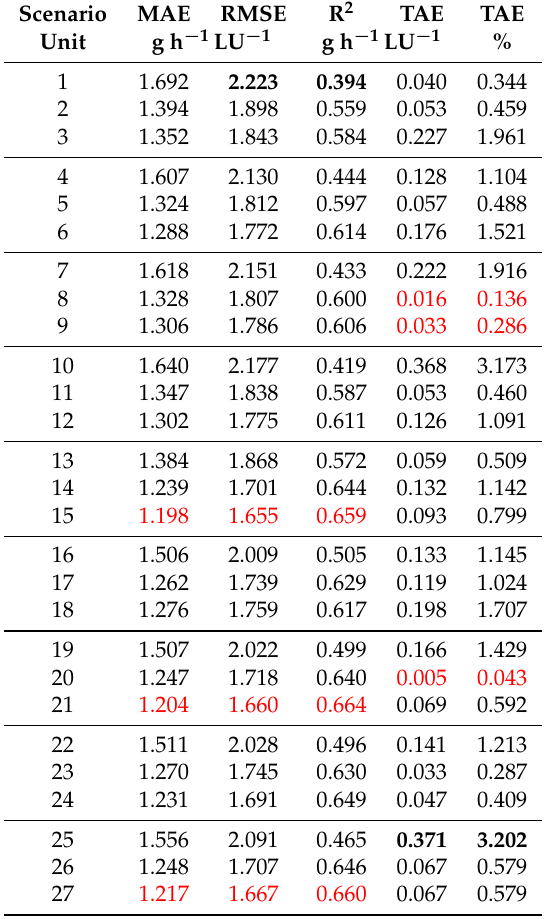
Table 3. Mean absolute error (MAE in g h − 1 LU − 1 ), root mean squared error (RMSE in g h − 1 LU − 1 ), coefficient of determination (R 2 , dimensionless) and total absolute error (TAE in g h − 1 LU − 1 ), calculated for gradient boosting on data disjoint from train and test sets. In addition, the total average error relative to the average observed emission value (%TAE in%) is provided. Red color highlights the best three results and bold face the worst results. The three lowest error values of MAE, RMSE and R 2 resulted from the scenarios 15, 21 and 27, while scenarios 8, 9 and 20 produced the lowest TAE.